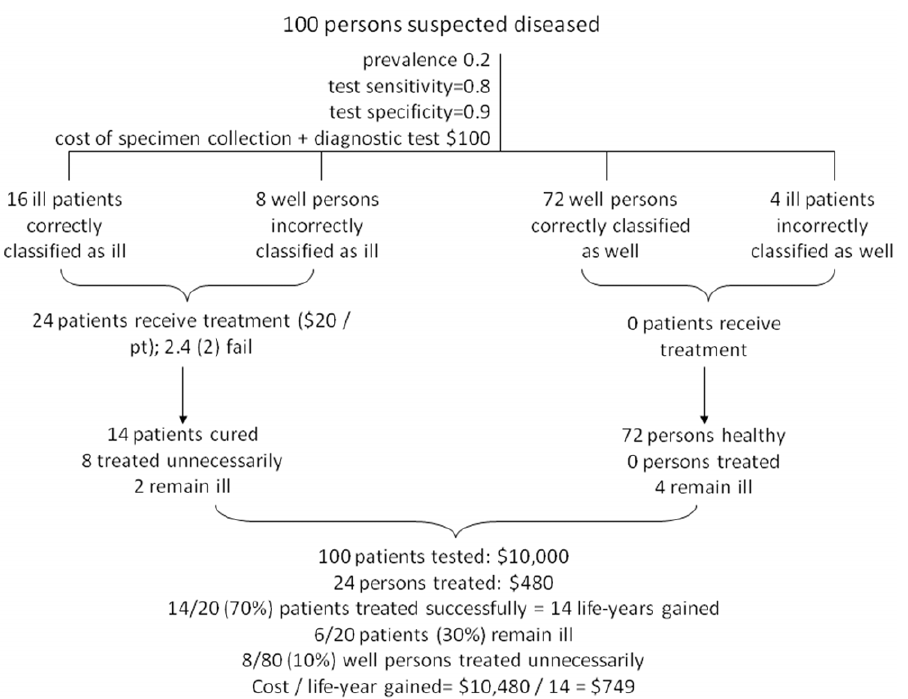
Figure 1. Model flow. ‘Ill patients’ refers to patients with PCP. ‘Well persons’ refers to persons without PCP, regardless of their health status otherwise. Patients successfully treated are assumed to gain one life-year.